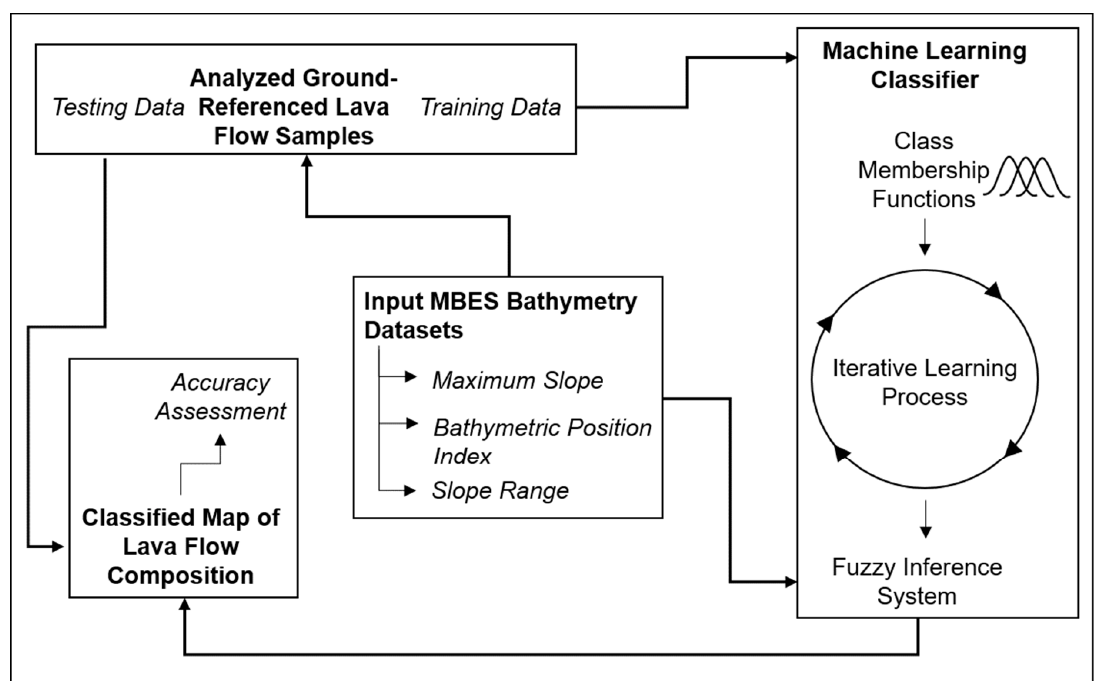
Figure 9. Adaptive neuro-fuzzy inference system (ANFIS) classification workflow. Ground-reference samples of basalt or rhyolite are divided into independent testing and training datasets. Slope, BPI at the 500 m scale, and slope range values are extracted at the training datapoints. The classifier then creates membership functions and classification rules. The resulting fuzzy inference system (FIS) classifies every 4 m 2 of seafloor with a probabilistic estimate of belonging to a rhyolite or basalt class.